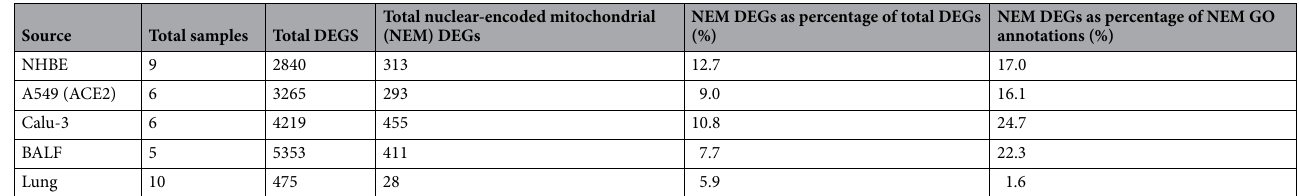
Table 1. The number of differentially expressed genes (DEGs) and NEM DEGs per biological source. A DEG was considered an NEM according to